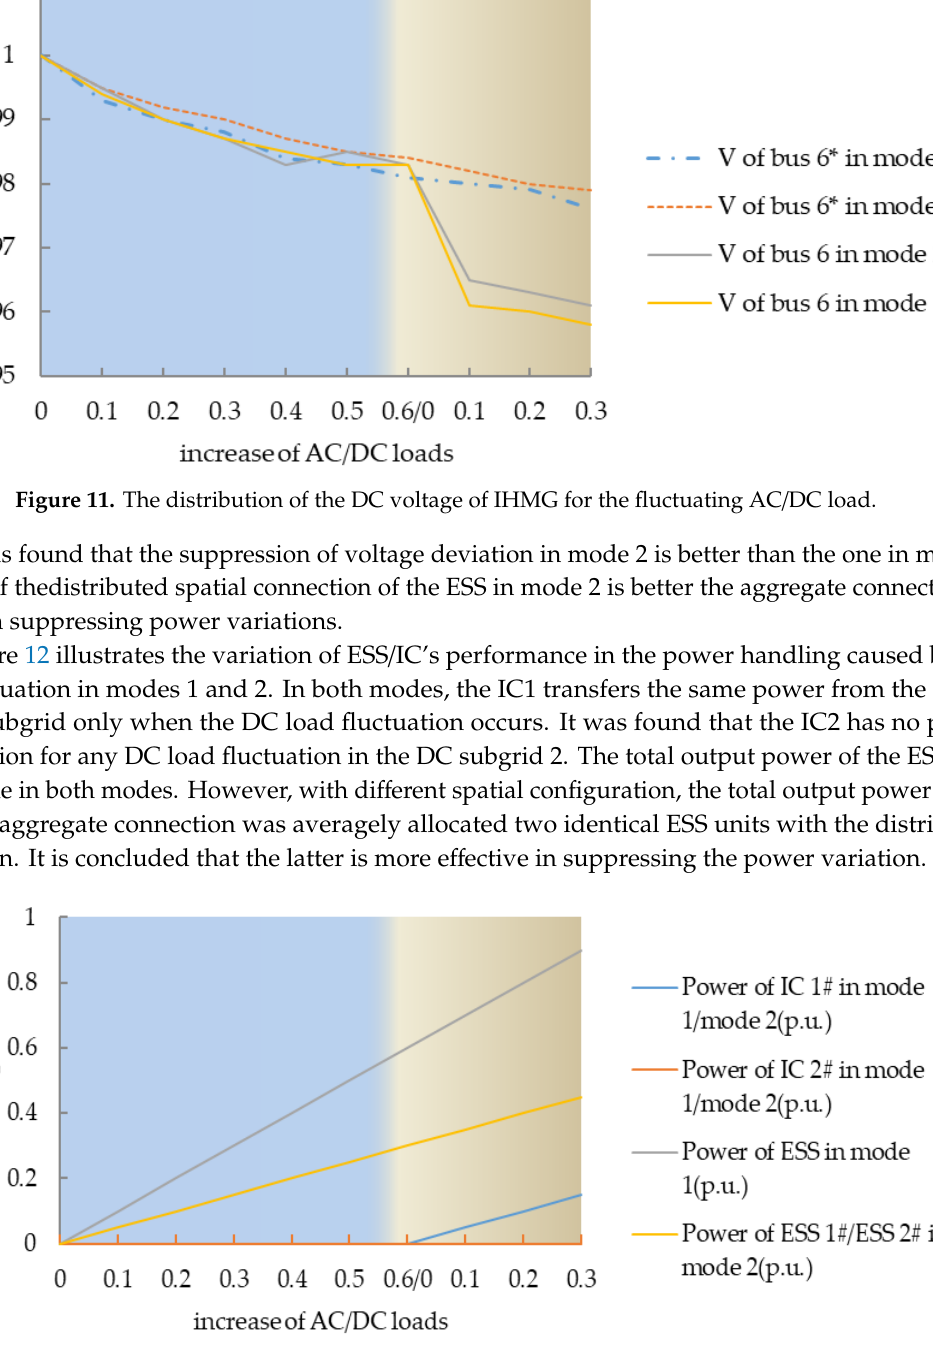
Figure 12. distribution of the output power of the ESS/IC in IHMG for fluctuation AC/DC load.